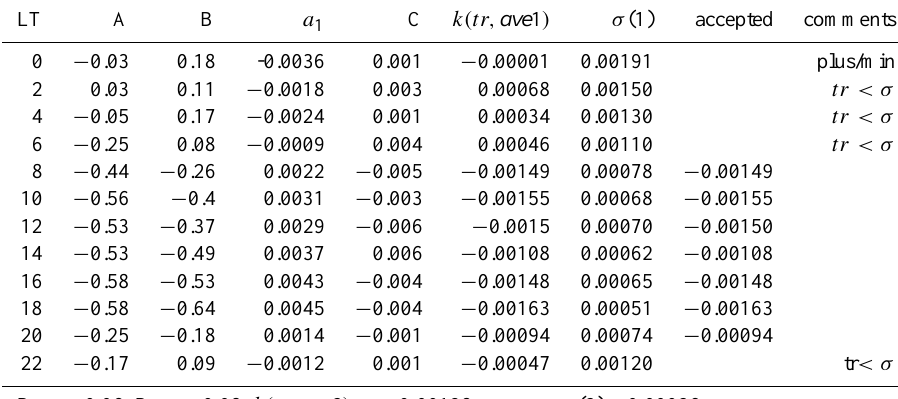
Table 1. Calculation of the trends for the Kiruna station